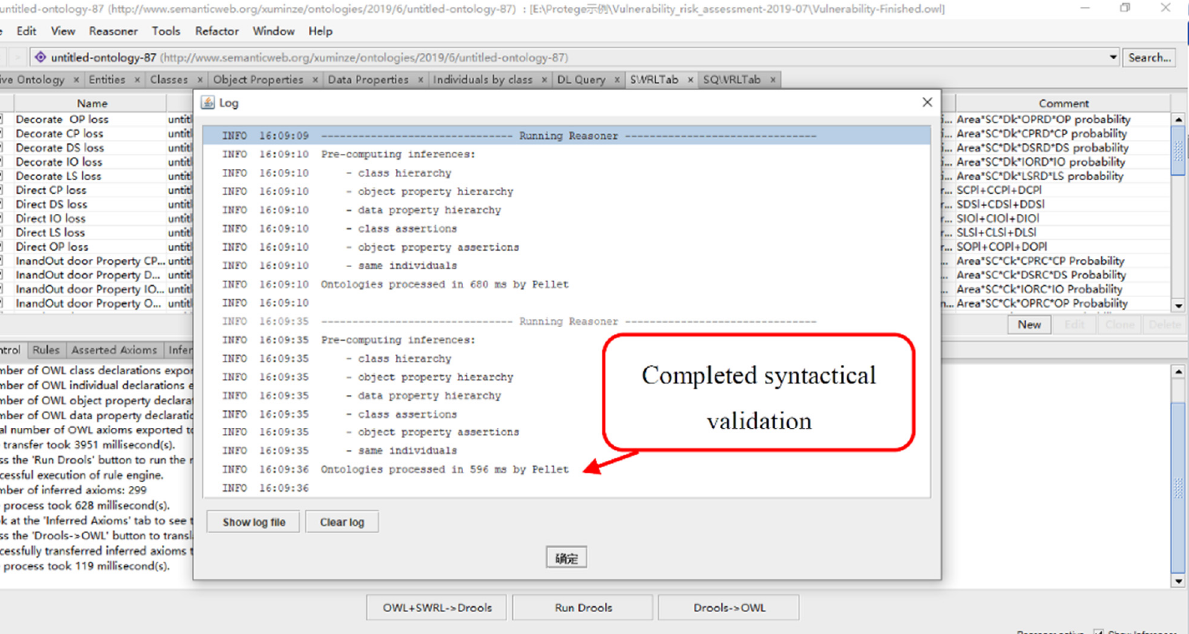
Figure 7. Syntactical validation of the OntoBSRA.